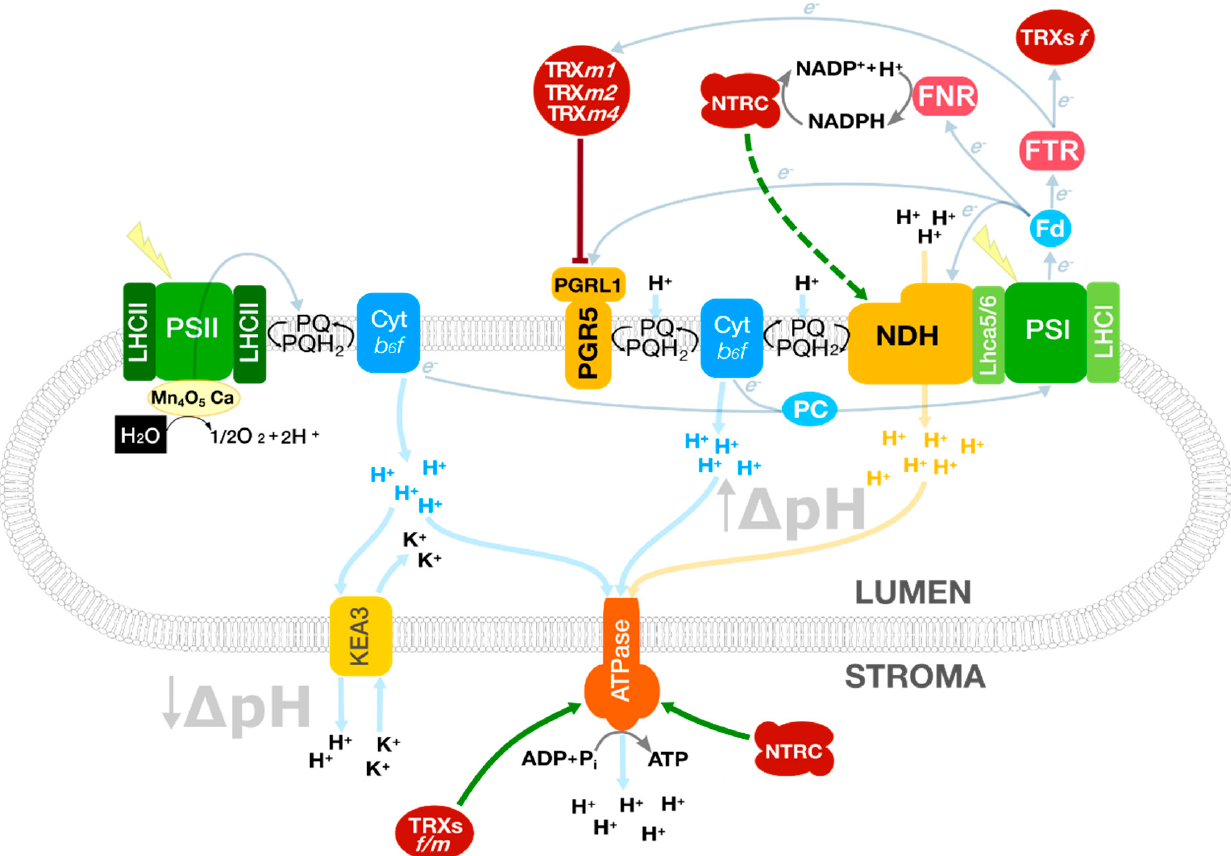
Figure 1. Photosynthetic processes involved in balancing the NADPH/ATP ratio in Arabidopsis chloroplasts. TRXs receive redox equivalents from the linear electron flow and control the cyclic electron flow to fine-tune the proton motive force and the ATP synthesis. At the same time, KEA3 modulates the ATPase activity controlled by TRXs f/m and NTRC. The soluble electron carriers ferredoxin (Fd) and plastocyanin (PC) operate at both sides of the thylakoid membrane connecting PSI with the CEF complexes and Cyt b 6 f , respectively. Green arrows represent direct activation mediated by TRXs or NTRC; truncated red lines, inhibition. A dashed line indicates a hypothetical interaction. Protein complexes were schematised for a better understanding.